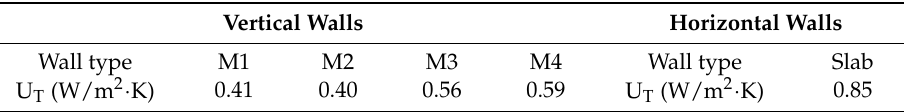
Table 3. Thermal transmittance through